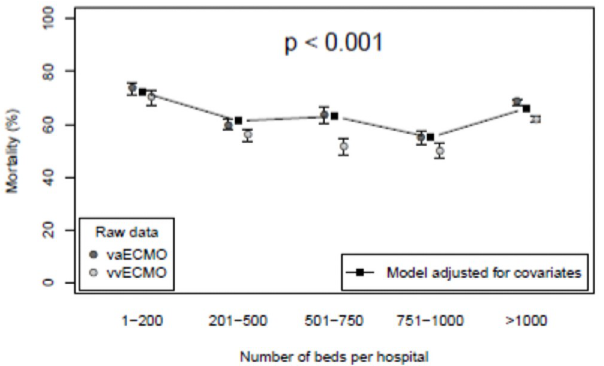
Fig 2. Mortality and hospital size. Mortality for patients is shown according to ECMO hospital size. The points connected by lines are taken from a logistic regression model adjusting for ECMO type, age and sex. A 61–70 year old, male vaECMO patient is depicted, but this choice does not affect the relative positions.